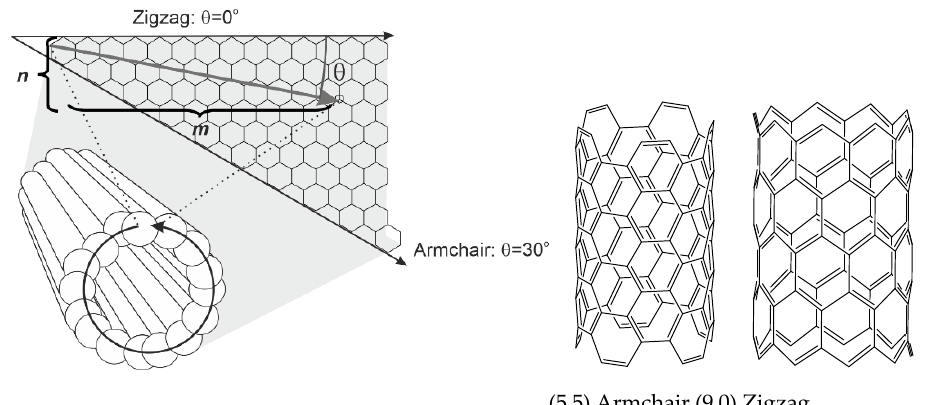
Figure 2. Outline of the single-walled carbon nanotube (SWCNT) tubes (armchair and zigzag configurations) and explanation of the chirality angle.